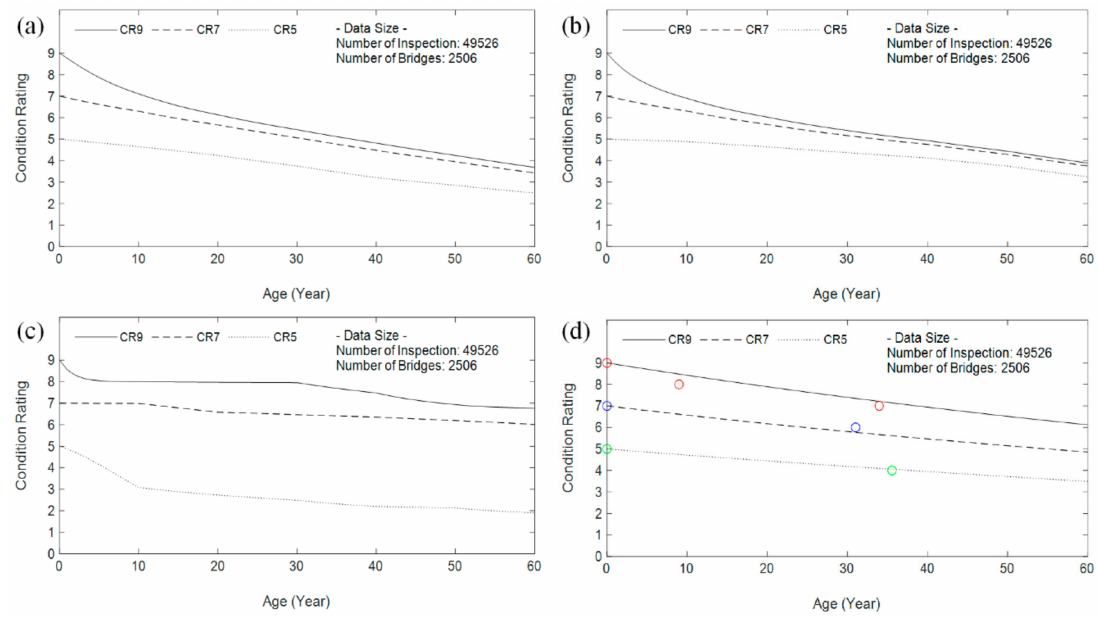
Figure 10. Deck deterioration models for all Wyoming bridges using ( a ) percentage prediction, ( b ) logistic regression, ( c ) optimization algorithm, and ( d ) Weibull